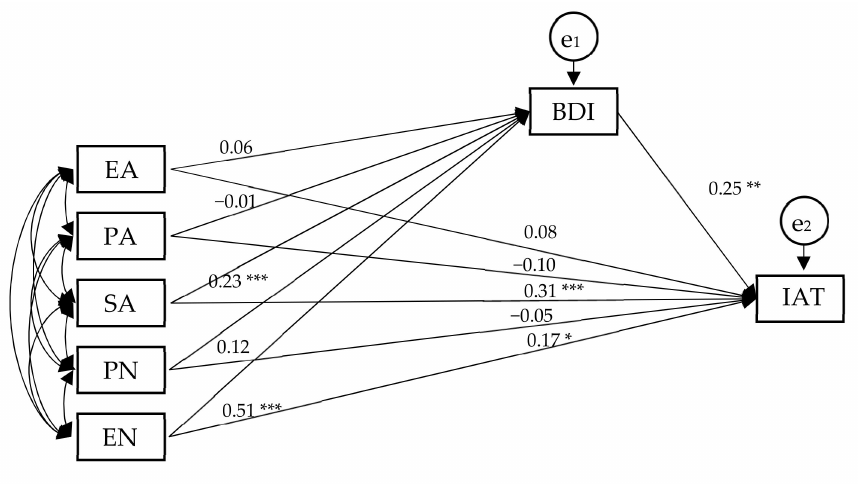
Figure 5. Path analysis of childhood trauma (CTQ subscores), the severity of depression (BDI score) and internet addiction (IAT score) for female internet-addicted individuals. EA = emotional abuse subscale; PA = physical abuse subscale; SA = sexual abuse subscale; EN = emotional neglect subscale; PN = physical neglect subscale. e1 and e2 represent the error terms of the BDI and IAT scores. The value on each path indicates the standardized coefficient. ***: p < 0.001; **: p < 0.01; *: p <